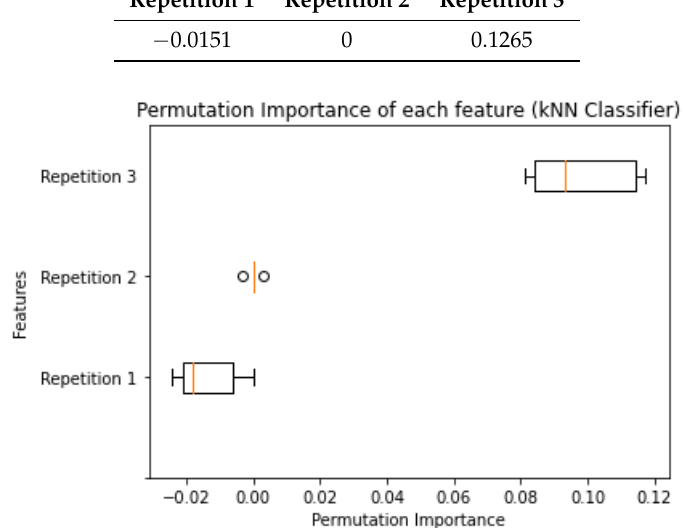
Figure A1. kNN features predictive weight ( Importance Mean ) obtained through permutation feature importance.